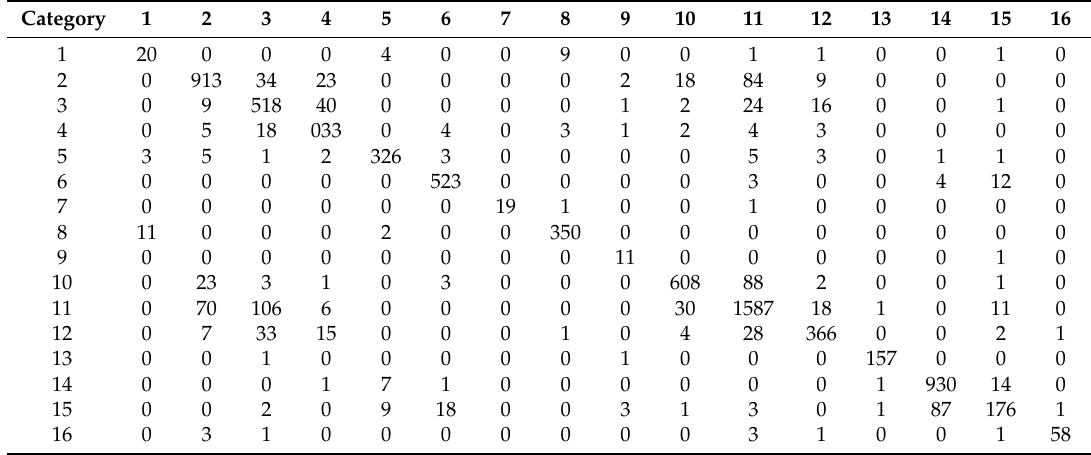
Table 7. Confusion matrix for traditional CNN classification used Indian Pines dataset.